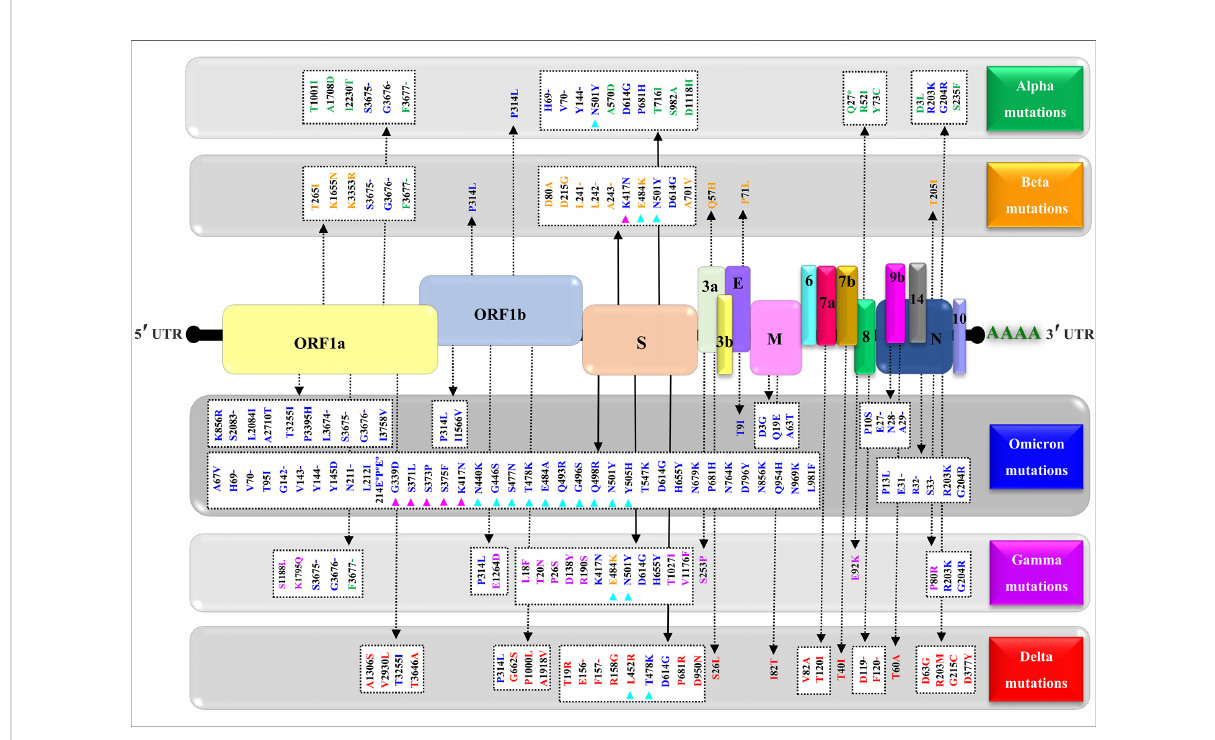
FIGURE 4 Mapping of the nonsynonymous mutations ’ characteristics of the SARS-CoV-2 four variants. A typical genomic organization of SARS-CoV-2 contains the following: 5 ’ end UTR; open reading frames: ORF 1a and ORF 1b; the structural genes coding for the Spike (S) protein, the Envelope (E), the Membrane (M), and the Nucleocapsid. The accessory genes such as 3a, 3b, 6, 7a, 7b, 8, 10, and 14 are distributed among the structural genes. The 3 ’ end UTR follows the poly (A) tail. The green, yellow, blue, purple, and red show, respectively, the synonymous mutations characteristic of the alpha ( a ) variant (B.1.1.7), beta ( b ) variant (B.1.351), omicron (o) variant (B.1.1.529), gamma ( g ) variant (P.1), and delta ( d ) variant (B.1.617.2). The (-) represents the deletion, (°) represents the insertion, (*) represents the stop codon, magenta triangles indicate variations in the receptor-binding domain (RBD), and cyan triangles denote variations in the receptor-binding motif (RBM). The NCBI reference sequence for the surface glycoprotein of SARS-CoV-2 is